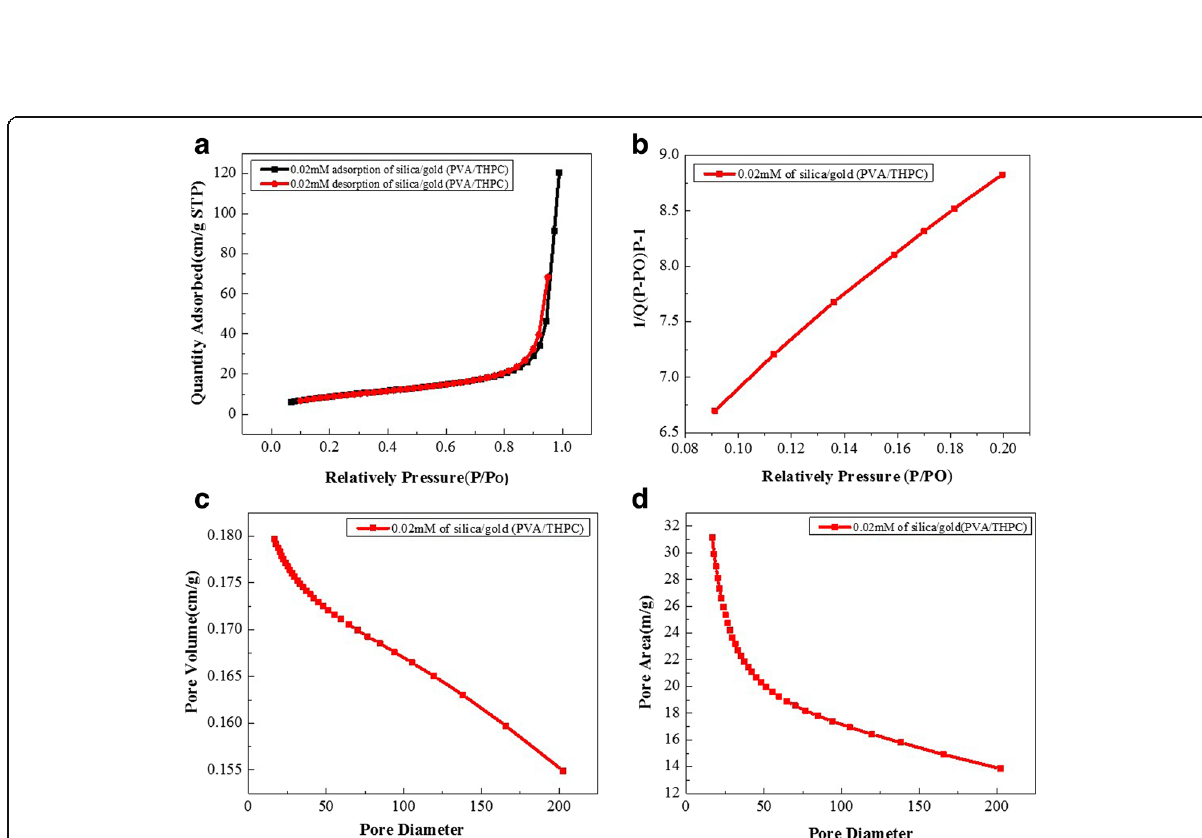
Fig. 12 (a-d) BET results of cellulose-amino POSS hybrid composite by PVA/THPC